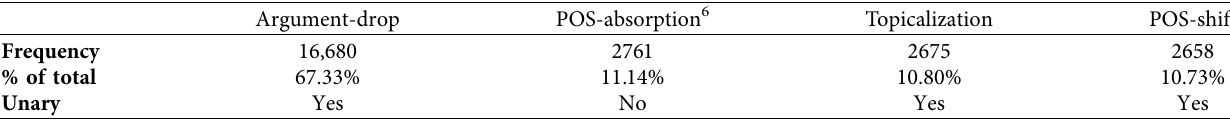
Table 3: NCR subtypes in Chinese CCGbank (CASS).